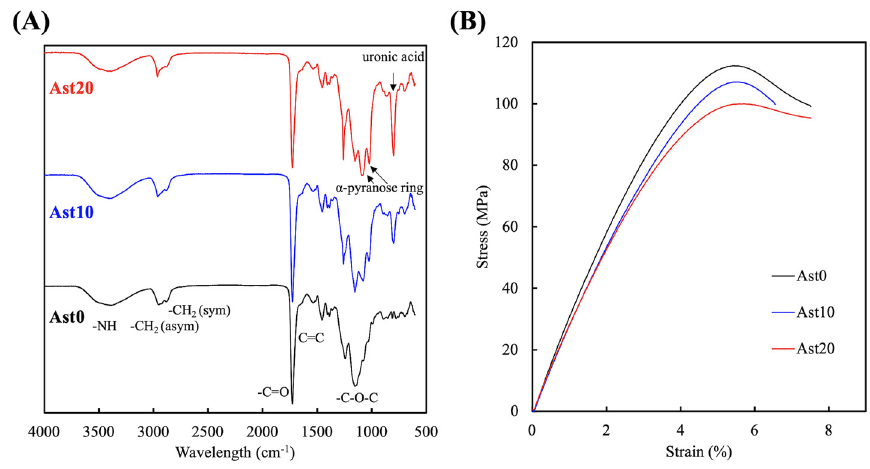
Figure 3. ( A ) Fourier transform infrared spectroscopic (FTIR) spectra and ( B ) tensile stress–strain curves of the various 3D-printed Ast-containing PU nerve conduits.